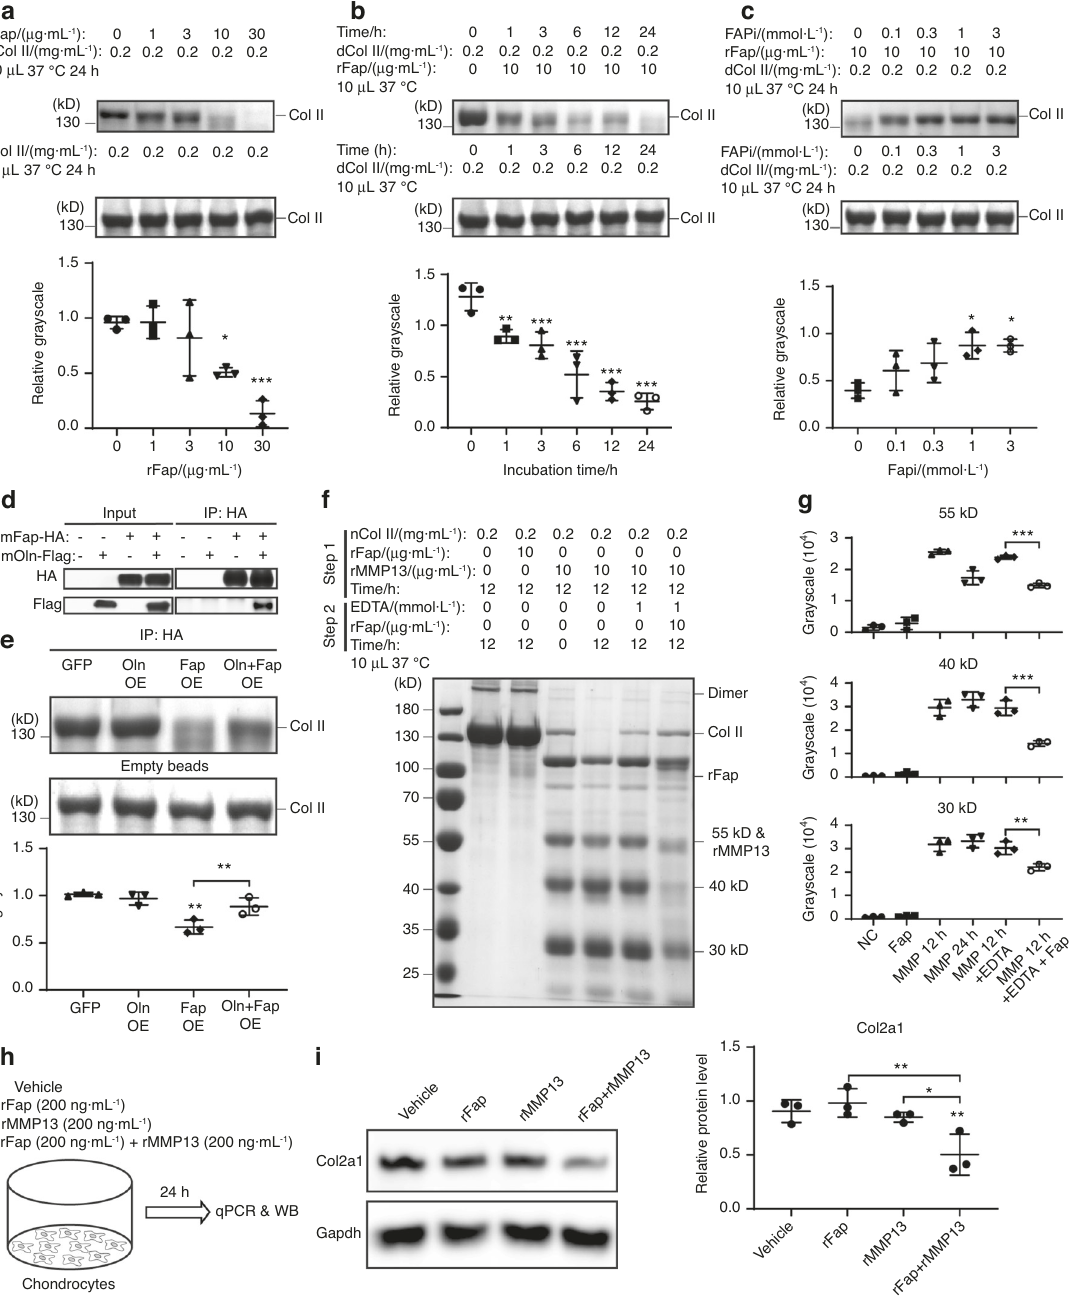
Fig. 4 Fap degrades denatured or MMP13-cleaved Col II. a Fap degrades denatured Col II in a dose-dependent manner. Denatured Col II (boiled at 95 °C for 10 min) was incubated with different amounts of rFap at 37 °C for 24 h. Samples were separated by SDS ‒ PAGE and quanti fi ed by colloidal blue staining ( n = 3 independent experiments). b Fap degrades denatured Col II in a time-dependent manner. Denatured Col II was incubated with rFap at 37 °C for 0 – 24 h ( n = 3 independent experiments). c FAPi inhibits Fap-mediated degradation of denatured Col II. Different doses of FAPi were preincubated with rFap for 30 min before denatured Col II was added and further incubated at 37 °C for 24 h ( n = 3 independent experiments). d Immunoprecipitation of Fap. HEK293T cells were transfected with GFP control, Oln-Flag, Fap- HA, or Oln-Flag + Fap-HA. Two days after transfection, Fap was immunoprecipitated from total cell lysates with 10 μ L anti-HA af fi nity gel. Five percent total cell lysates were loaded as an input control ( n = 3 independent experiments). e Oln inhibits the Fap-mediated degradation of denatured Col II. Col II was coincubated with immunoprecipitated samples (in 10 μ L anti-HA af fi nity gel) at 37 °C for 24 h ( n = 3 independent experiments). f Fap degrades MMP13-cleaved Col II. Native Col II was preincubated with rFap or rMMP13 at 37 °C for 12 h. EDTA was then added to the reaction mixture with or without rFap and incubated at 37 °C for another 12 h ( n = 3 independent experiments). g Grayscale quanti fi cation of the 55, 40 and 30 kDa digestion bands in ( f ). h Experimental design. Primary chondrocytes were stimulated with